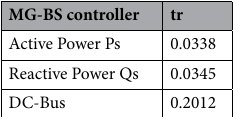
Table 1. summary of Backstepping controller response time.